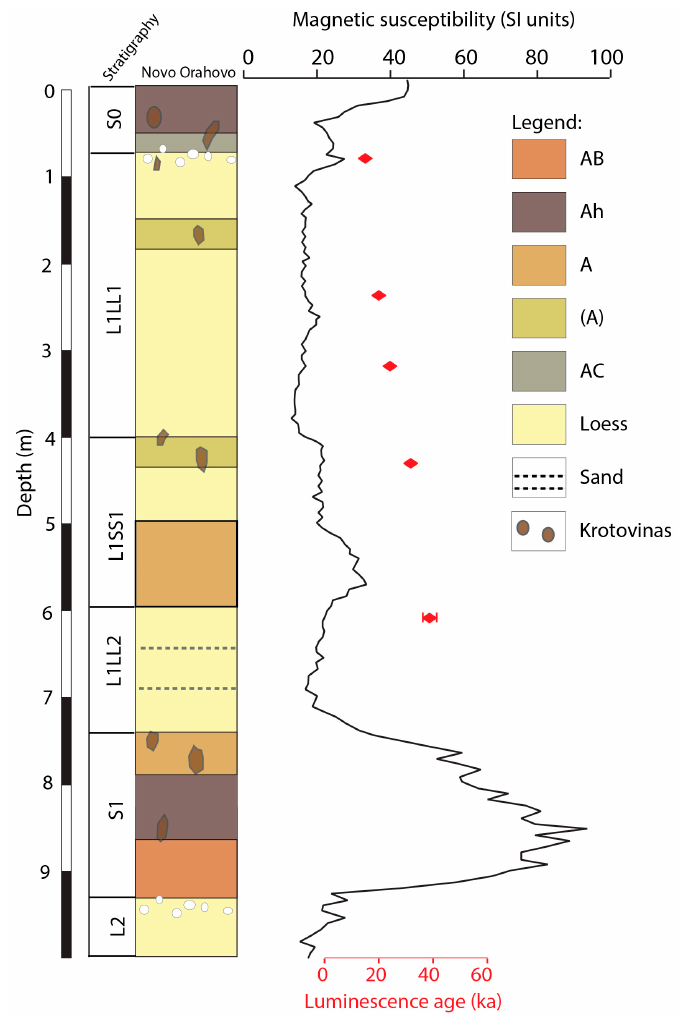
Figure 3. Magnetic susceptibility record (black line) and luminescence chronology (red dots) of the Novo Orahovo loess–paleosol sequence related to pedostratigraphy.